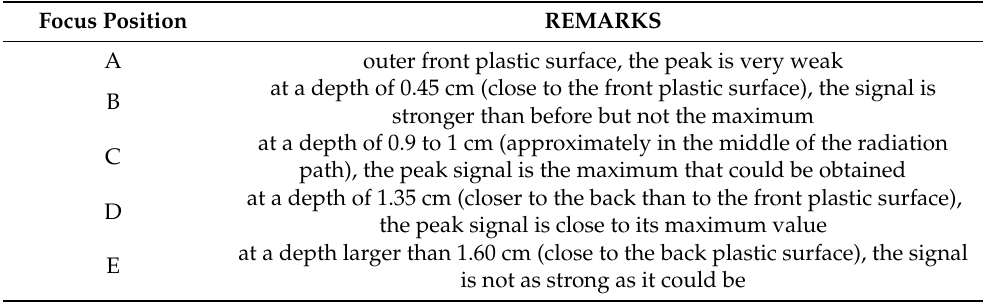
Table 7. Remarks on the focus position of the laser beam on the drip chamber of the IV set, in correla- tion with the respective spectrum received. The peak mentioned in the remarks is the characteristic PIP peak at 1003 cm − 1 .